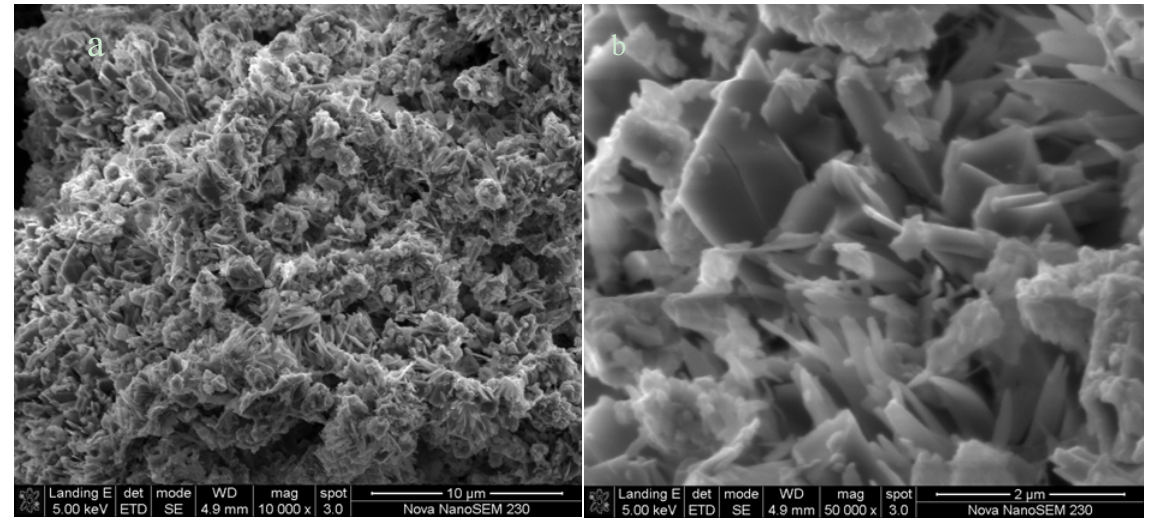
Figure 5. SEM images of zeolite Na-P1 synthesized with the 4-flat blade impeller